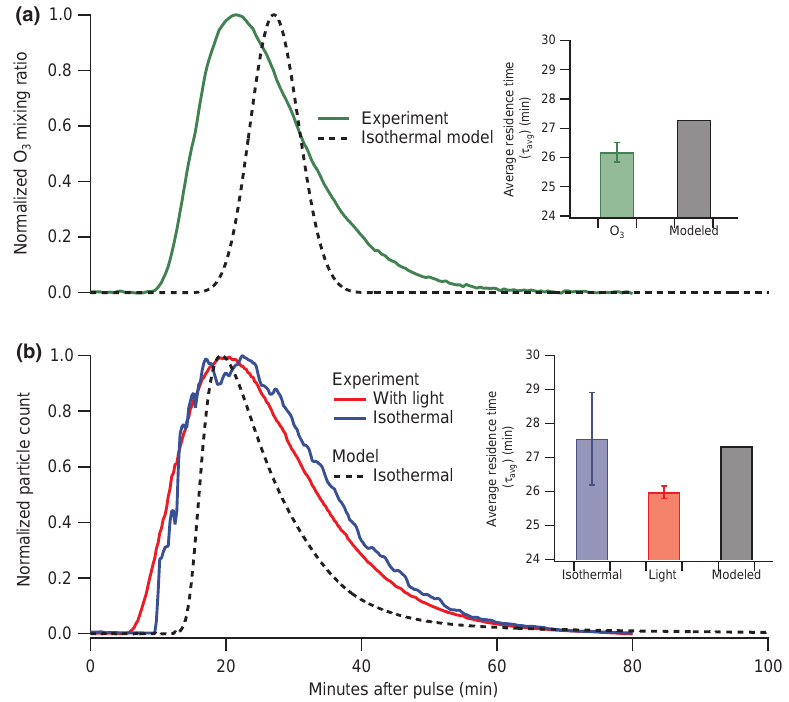
Figure 11. Experimental and COMSOL simulated residence time distributions of (a) O 3 vapor molecules and (b) polydisperse ammonium sulfate particles. The diffusivity used in COMSOL for O 3 is that for a generic gas-phase species 1 × 10 − 5 m 2 s − 1 and for particles is 1 × 10 − 9 m 2 s − 1 corresponding to a particle size of ∼ 100nm. The average residence time in each case is compared in the insets as